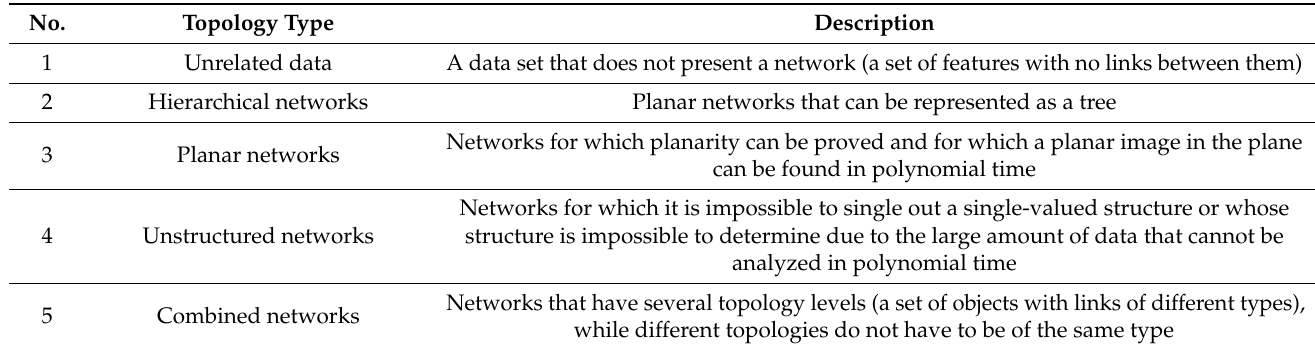
Table 1. Characteristics of network